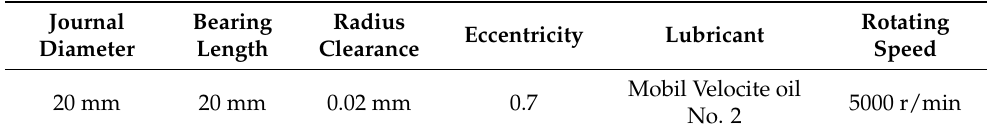
Table 1. Calculation parameters for radial hydrostatic